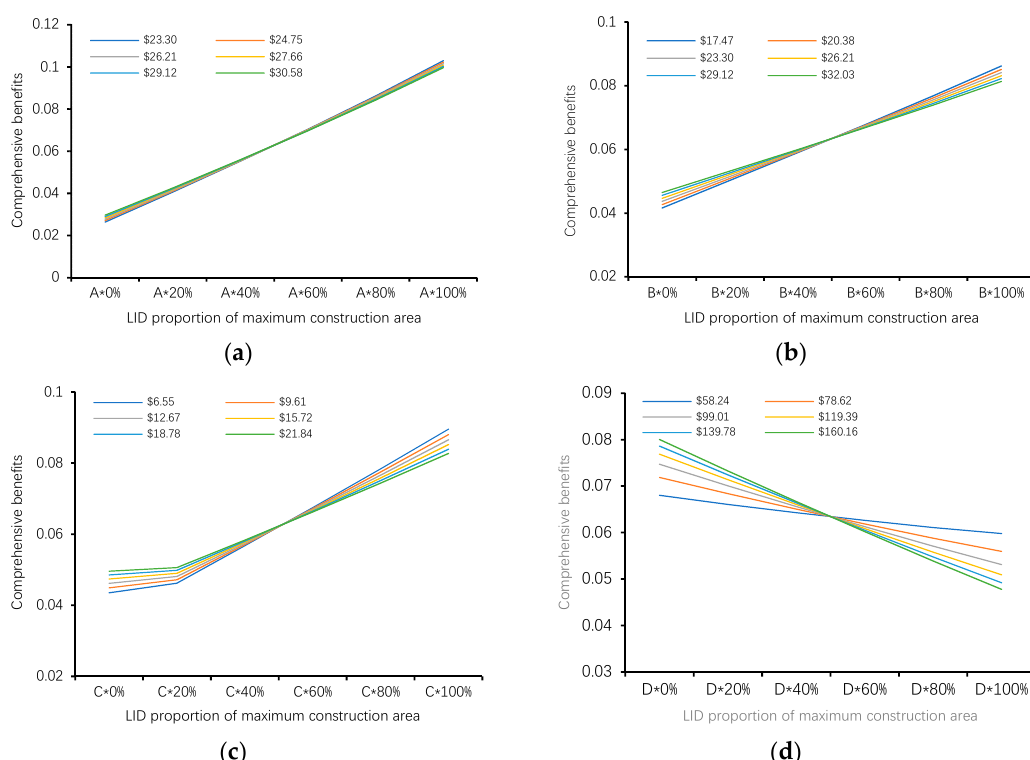
Figure 6. Comparison objective function values of different price conditions in various LID scenarios. ( a ) Comprehensive benefits of different price conditions of green roofs in scenario 1; ( b ) comprehensive benefits of different price conditions of permeable pavements in scenario 2; ( c ) comprehensive benefits of different price conditions of concave greenbelts in scenario 3; ( d ) comprehensive benefits of different price conditions of rain gardens in scenario 4.